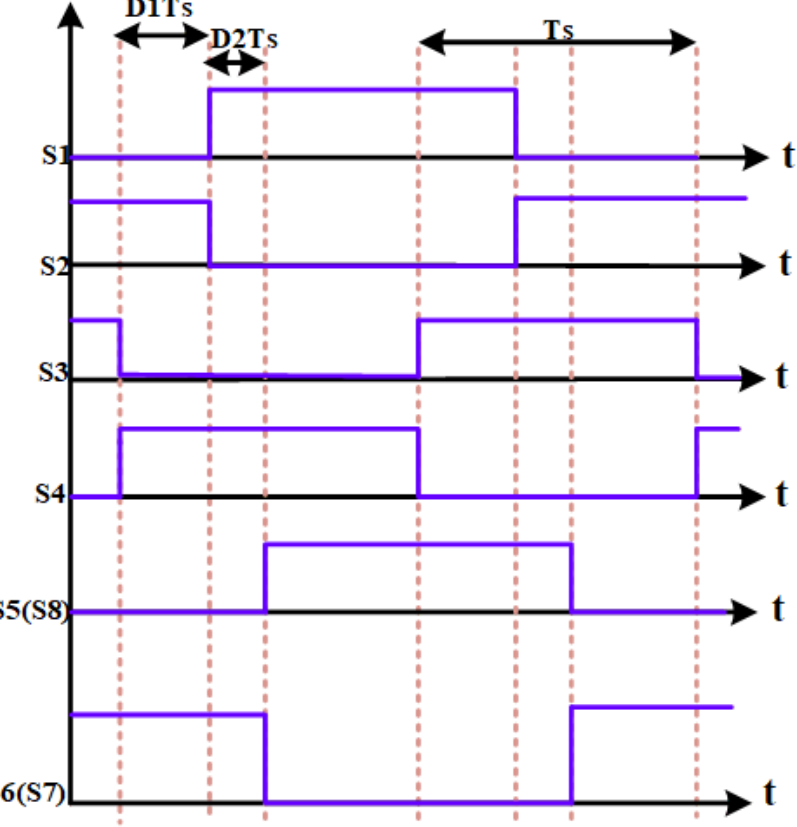
Figure 16. Dual-Phase Shift control switching pattern.